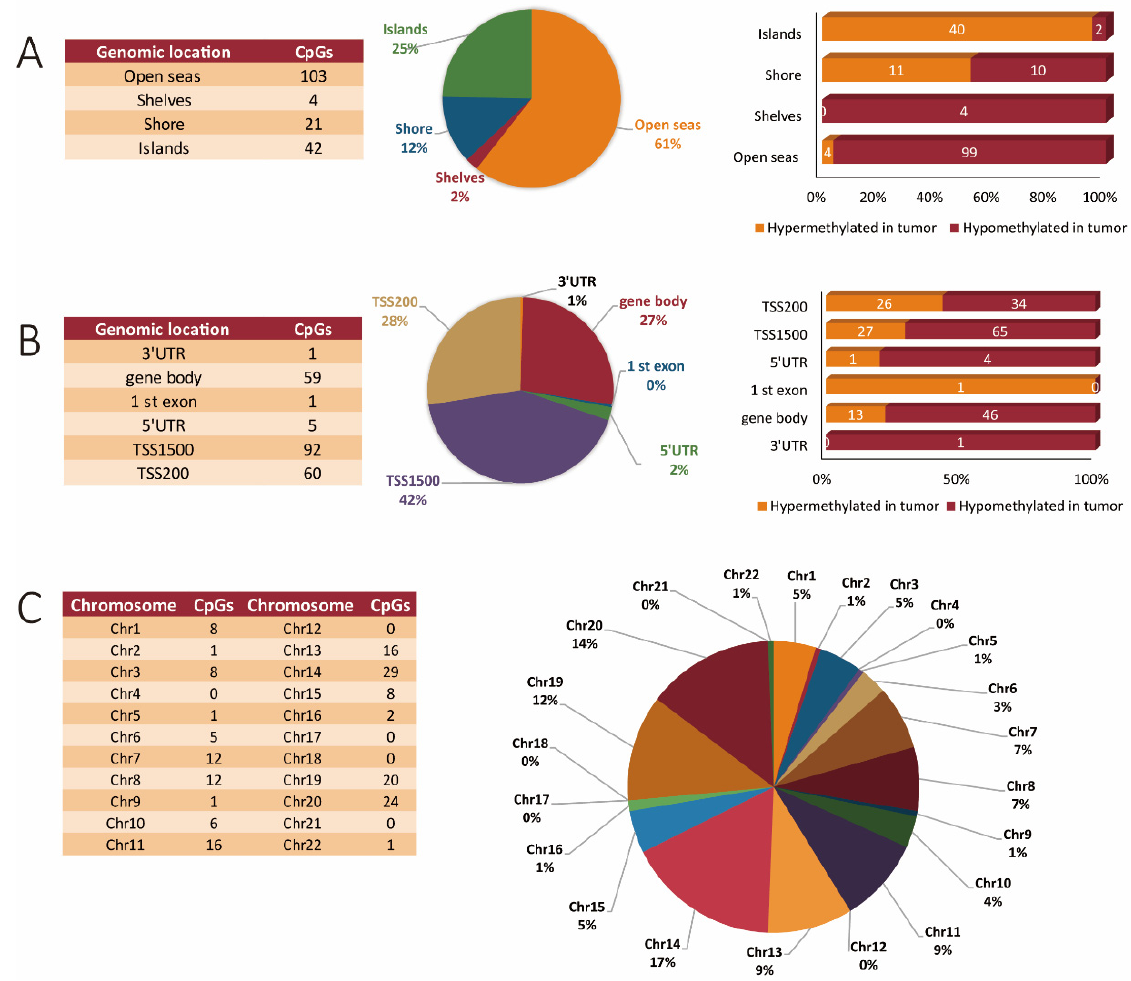
Figure 3. MiR gene methylation profiling in CRC tissues. ( A ) Genomic distribution of differentially methylated CpG sites in miR genes in relation to CpG islands, shores, shelves, and open sea regions. ( B ) The number and percentage of hypermethylated and hypomethylated CpG sites of miR genes ordered according to their functional genomic distribution. ( C ) Chromosome location of the differentially methylated sites of miR genes.